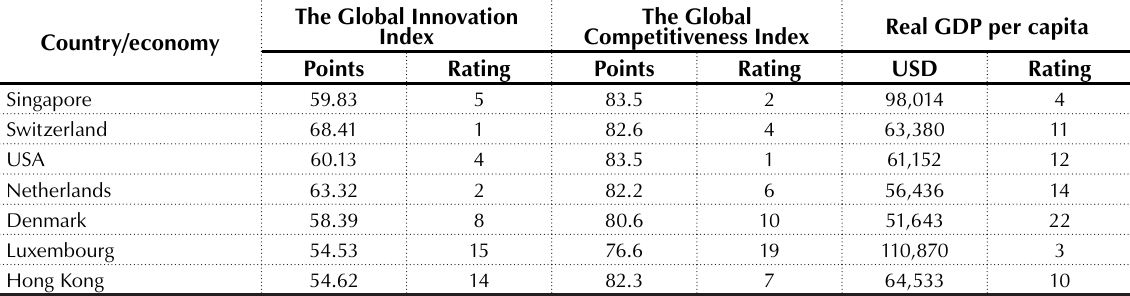
Table 1. Main indicators of the innovative development of the world’s major